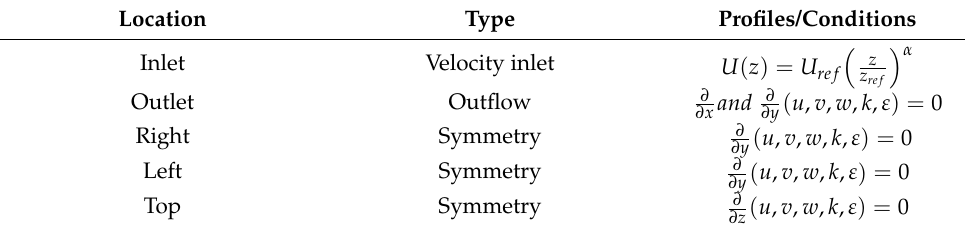
Table 1. Boundary conditions of the computational domain.